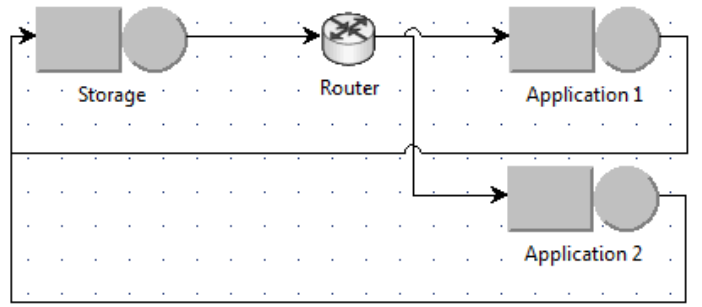
Figure 5. Intermediate scenario: two application VMs are used (asynchronous access).